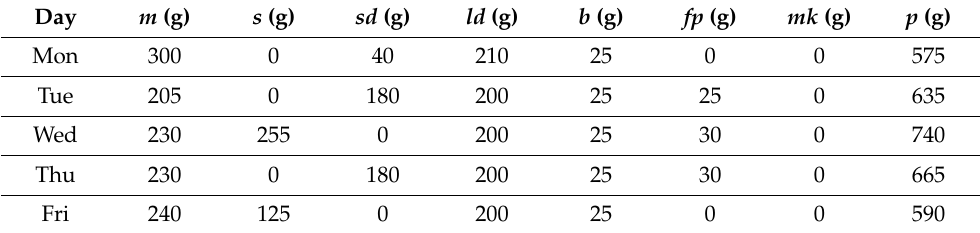
Table 2. Menus of schools in the observation